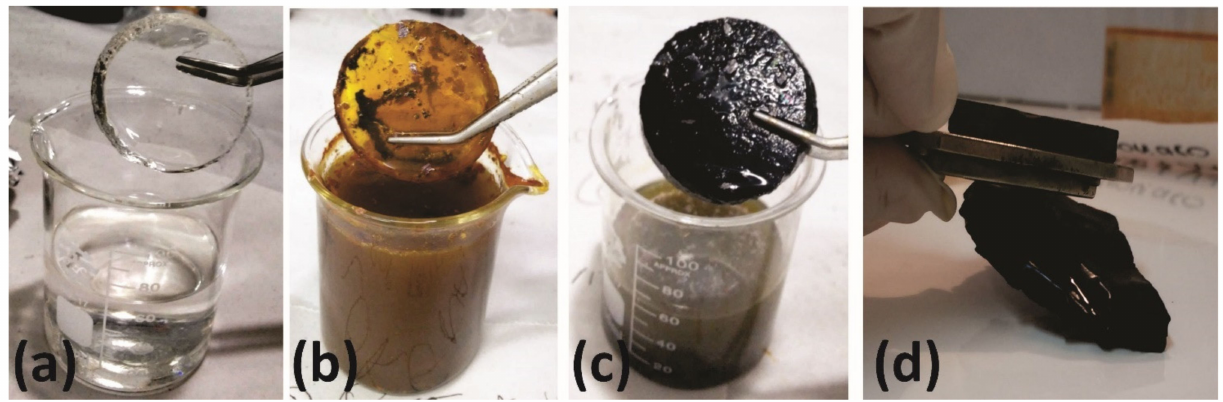
Figure 2. Photographs showing the steps of nanocomposite formation. ( a ) Elastomer swollen in ammonia for 24 h. ( b ) The system after immersion in aqueous solution of iron salts for 24 h. ( c ) The material after coprecipitation of magnetic nanoparticles by swelling in ammonia for 24 h. ( d ) Response of the obtained material to a